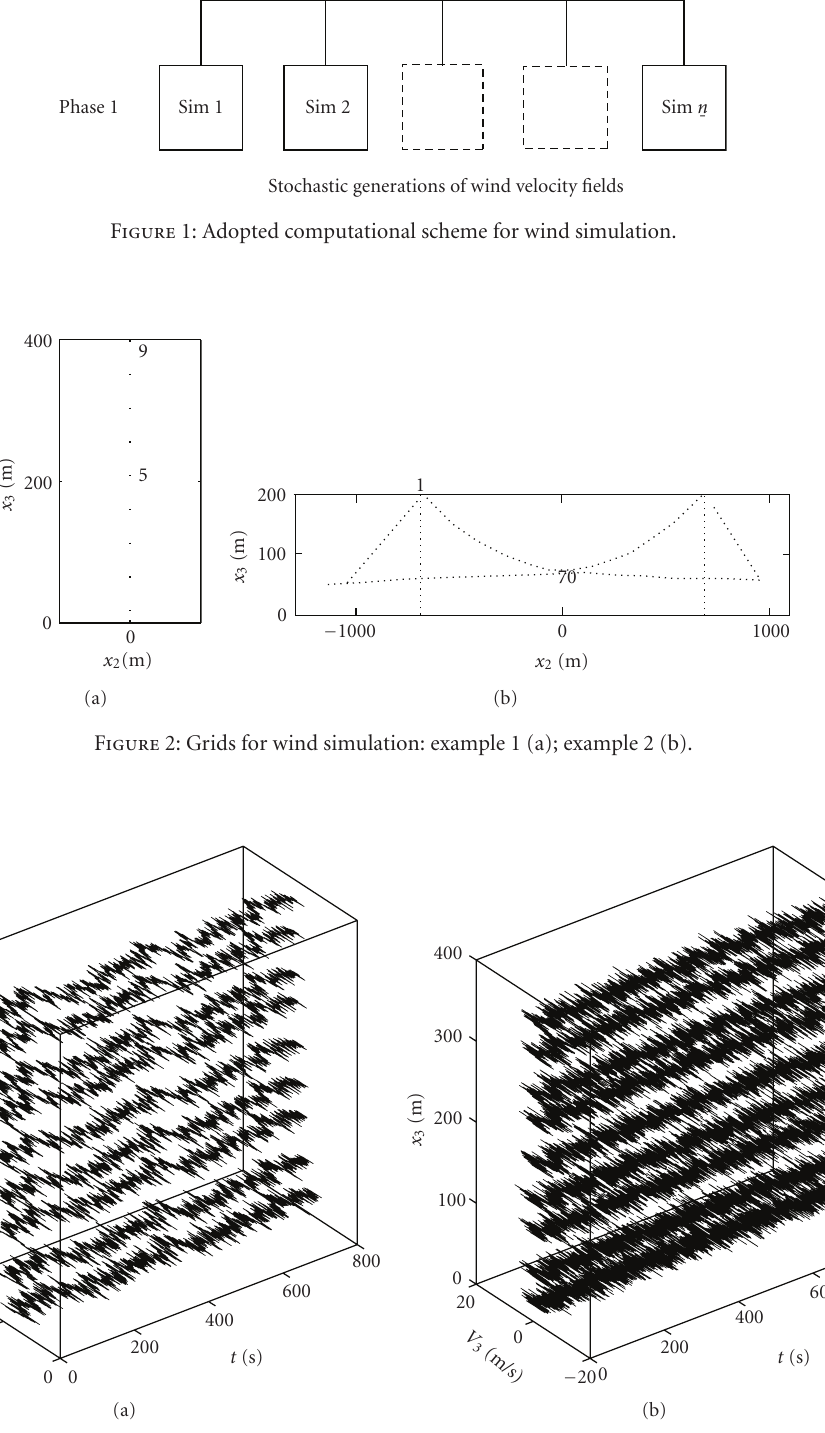
Figure 3: Example 1: wind velocity field sample generated using the WAWS method: along-wind velocities (a); across-wind velocities